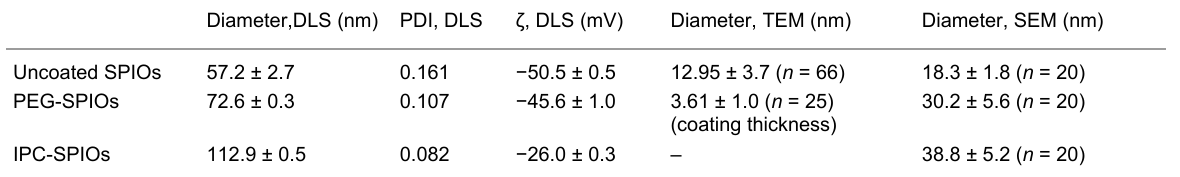
Table 1: Hydrodynamic diameter, polydispersity index (PDI), and zeta potential ( ζ ) of uncoated SPIOs, PEG-SPIOs, IPC-SPIOs with PEG and poly- gallol measured in triplicate using a Malvern Zetasizer ZS instrument. The diameters also were measured by TEM and